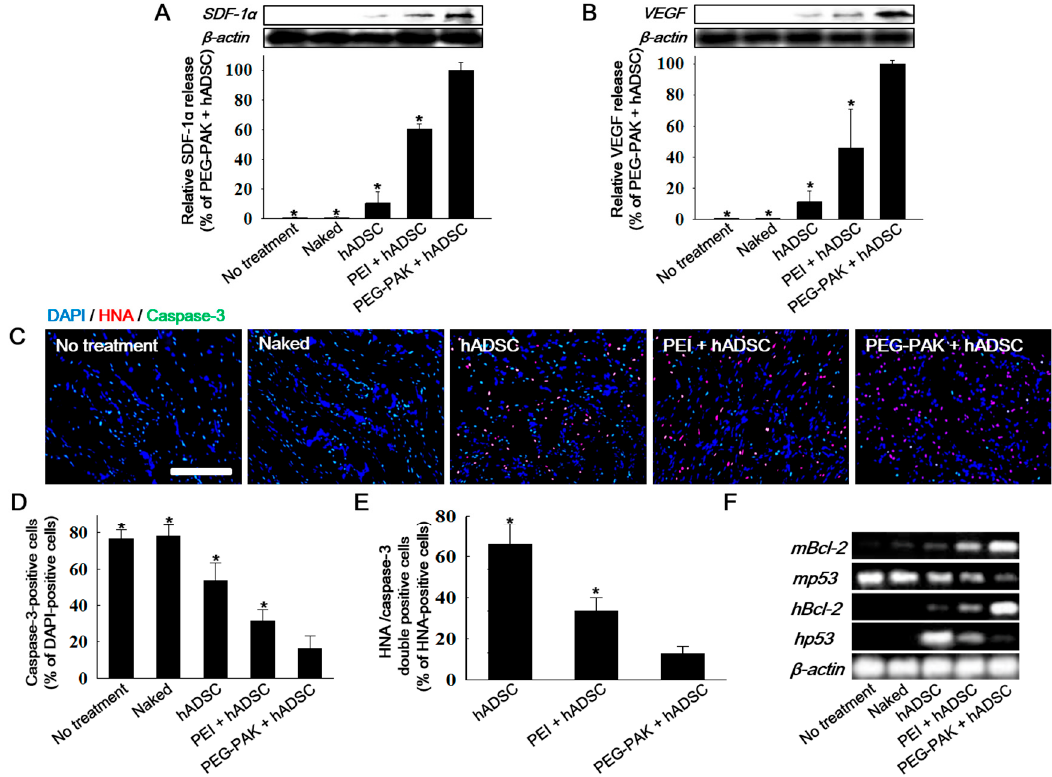
Figure 3. Western blot analysis and quantification of ( A ) SDF-1 α and ( B ) VEGF expression in the mouse hindlimb ischemia model 3 days after the various treatments; ( C ) Immunofluorescence staining of caspase-3 (green) and HNA (red) in ischemic limb tissues retrieved 3 days after treatment (blue indicates nuclei stained with 4 ′ ,6-diamidino-2-phenylindole (DAPI), scale bar = 100 μ m). Percentages of ( D ) caspase-3-positive cells (apoptotic cells) among DAPI-positive cells (total cells) and ( E ) HNA/caspase-3 double-positive cells (apoptotic hADSCs) among HNA-positive cells (hADSCs) in the ischemic region (* p < 0.05 compared with PEG-PAK + hADSC group); ( F ) RT-PCR analysis of human and mouse Bcl-2 (anti-apoptotic factor) and p53 (pro-apoptotic factor) in ischemic limbs.